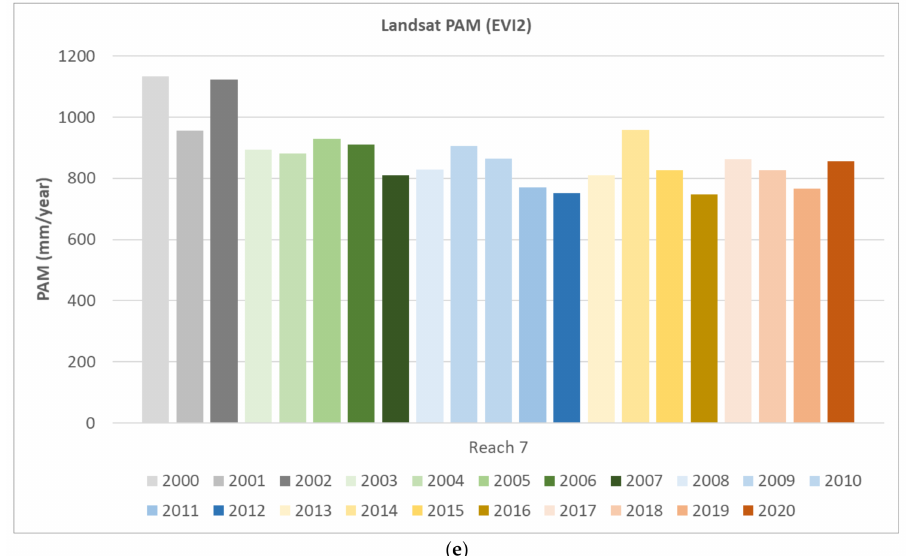
Figure A3. ( a – e ). Bars of PAM ET (mmyr − 1 ) based on EVI2 time-series information for the Lower Colorado River riparian